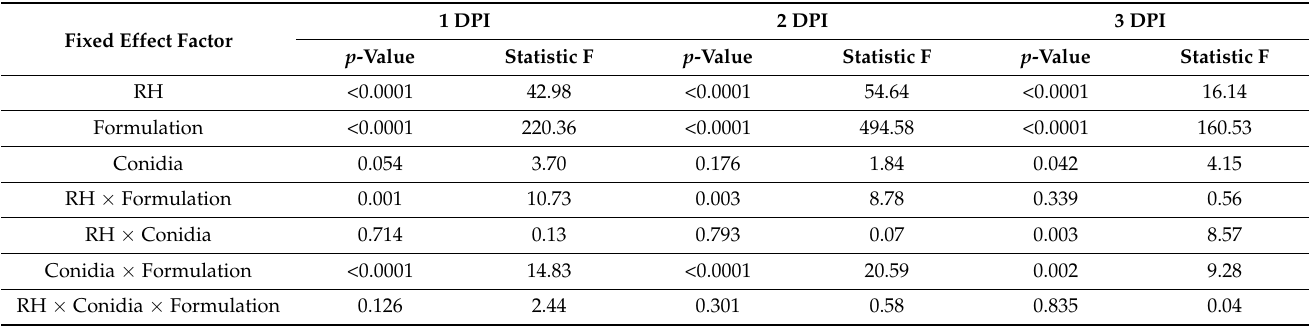
Table 5. Statistical significance of the effect of all fixed variables and their interactions on larval body length by days